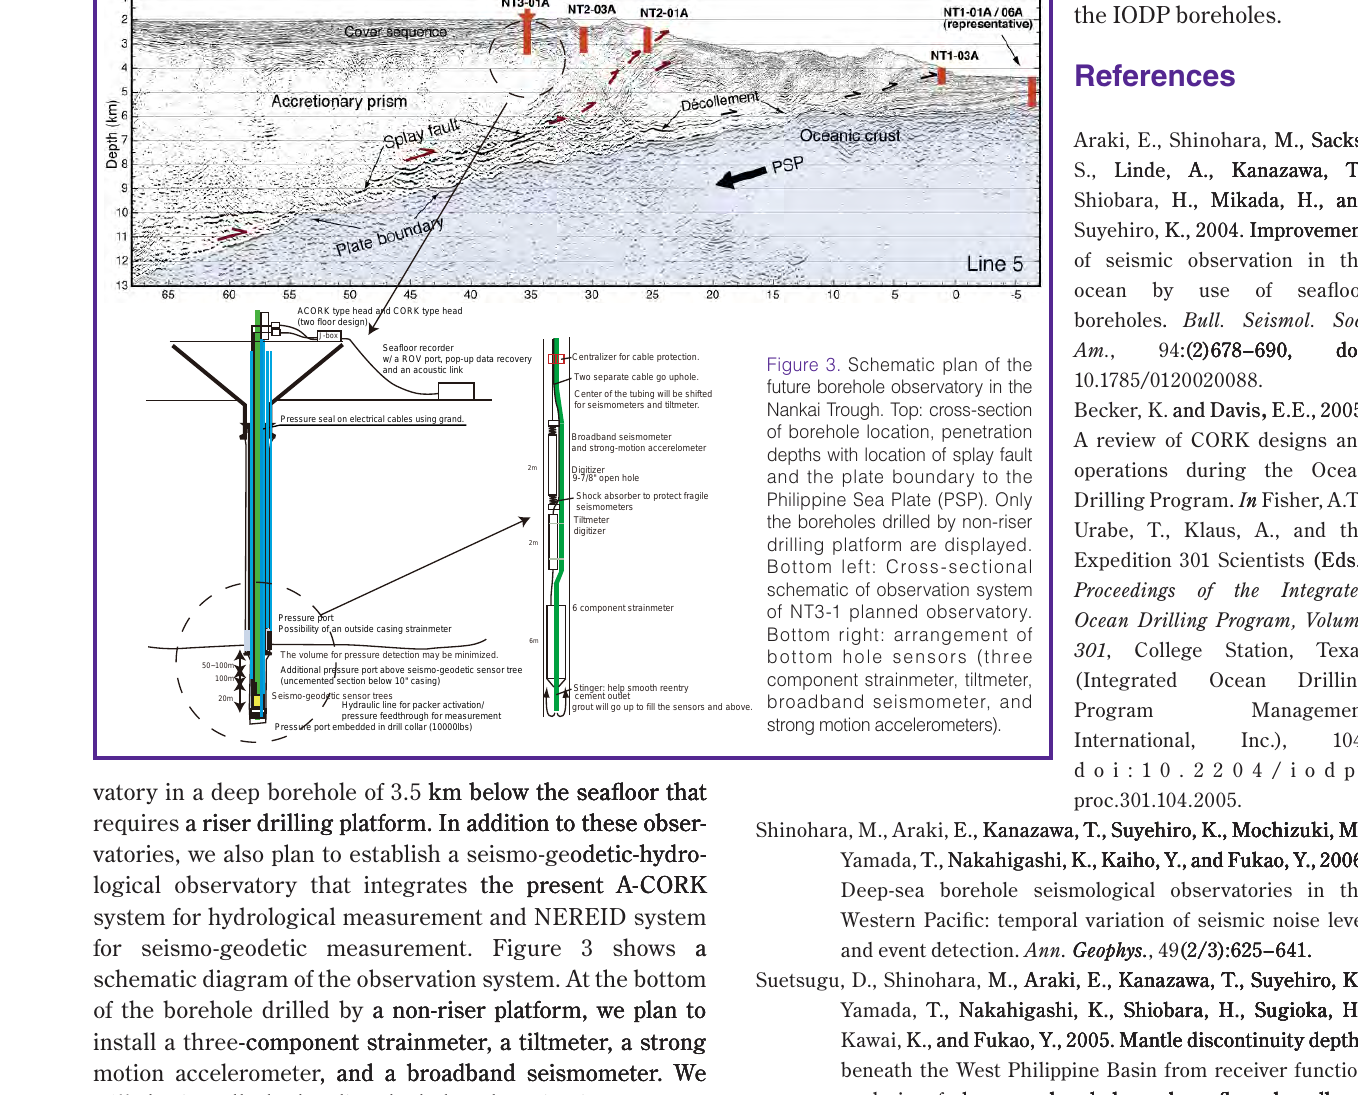
of seismic observation in the ocean by use of seafloor